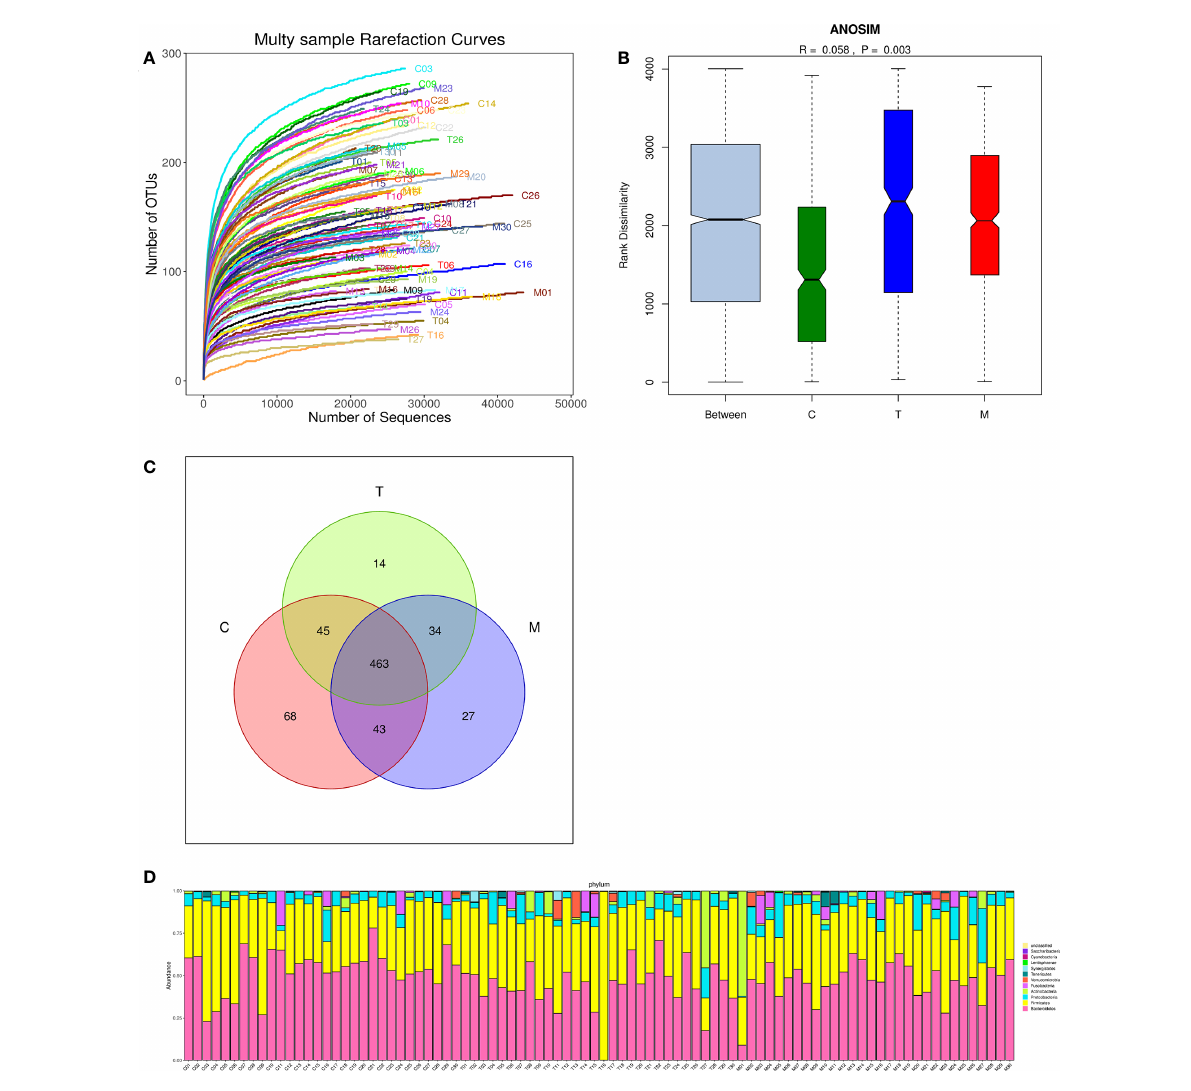
FIGURE 2 Multiple sparse curves for comparing the abundance of multifarious species (A) , Similarity analysis boxplot for identifying the existence of differences between groups (B) , Venn diagram for implying the common and speci fi c traits among three groups (C) , Histogram of the abundance distribution of species at the phylum level (D)